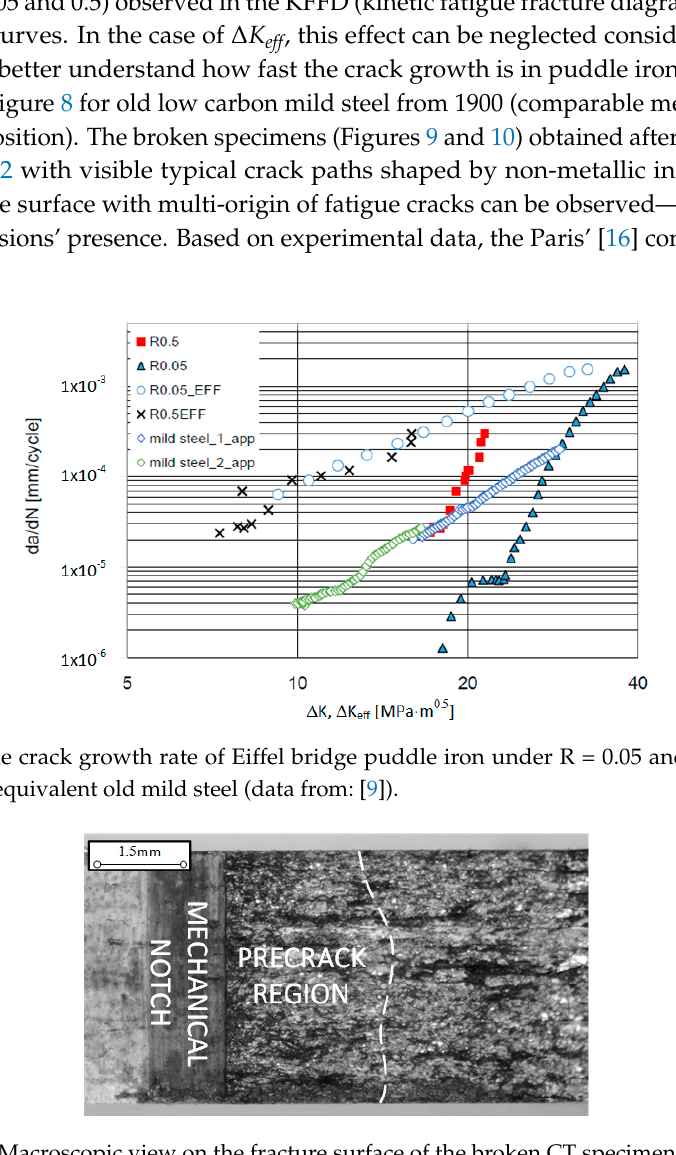
Figure 9. Macroscopic view on the fracture surface of the broken CT specimen (R = 0.5).